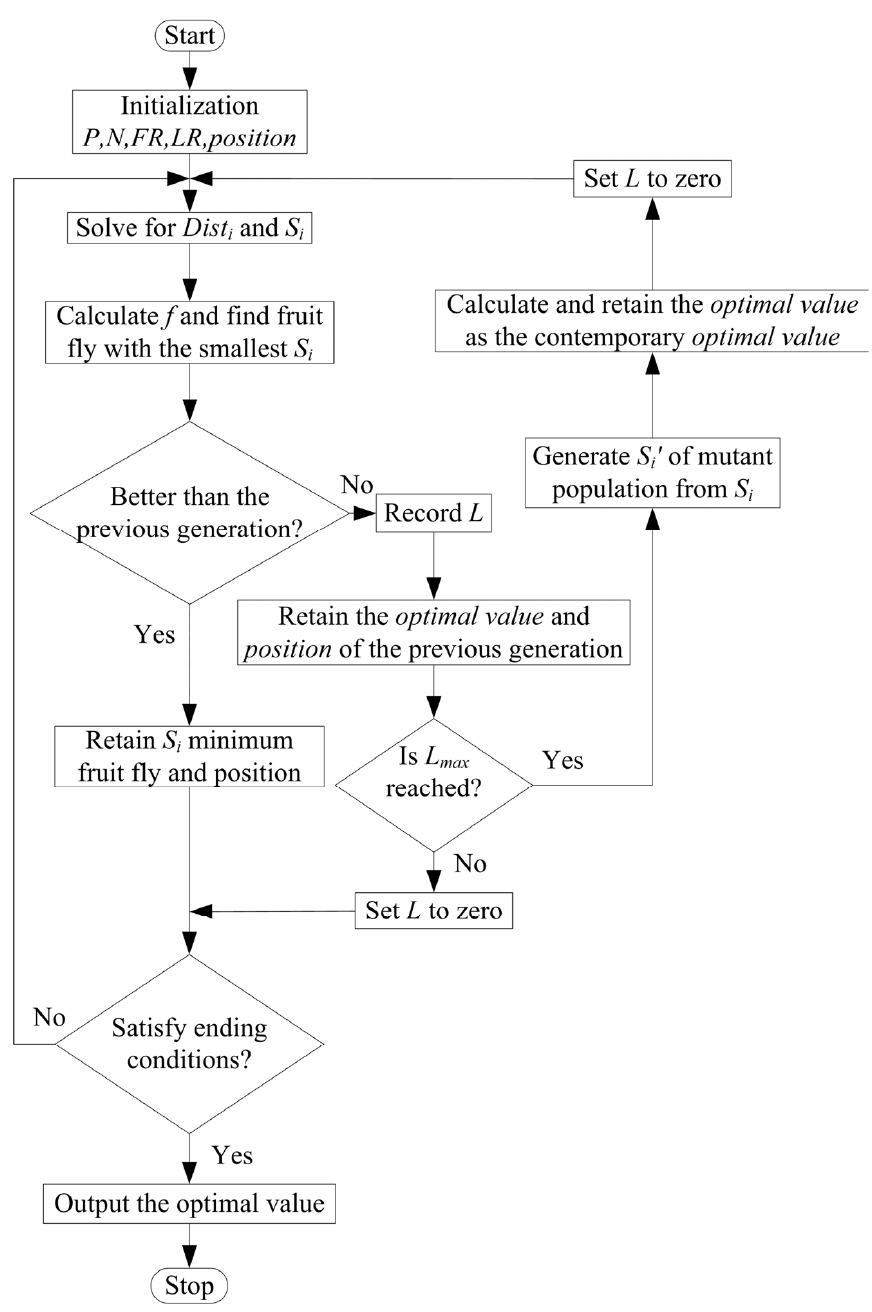
Figure 3. Flowchart of the IFOA.